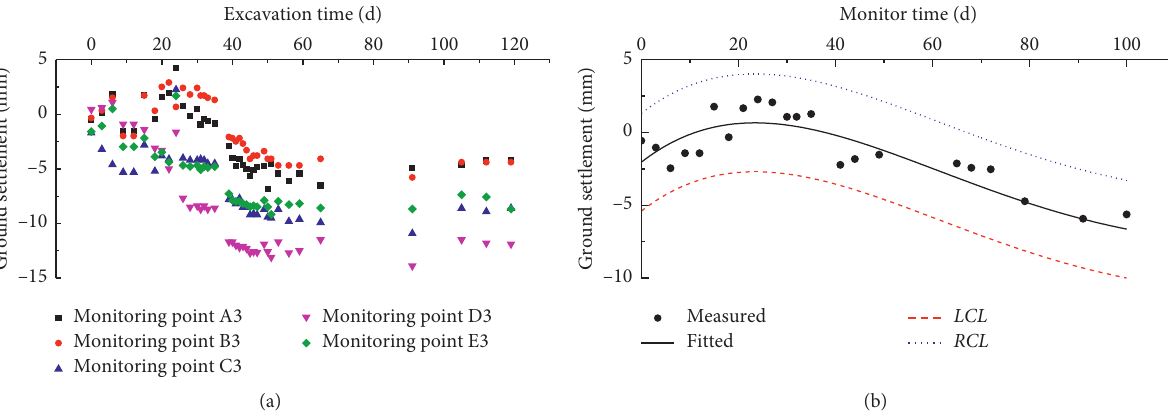
Figure 5: Ground settlement varying with (a) time in monitoring section A3-E3 and (b) control